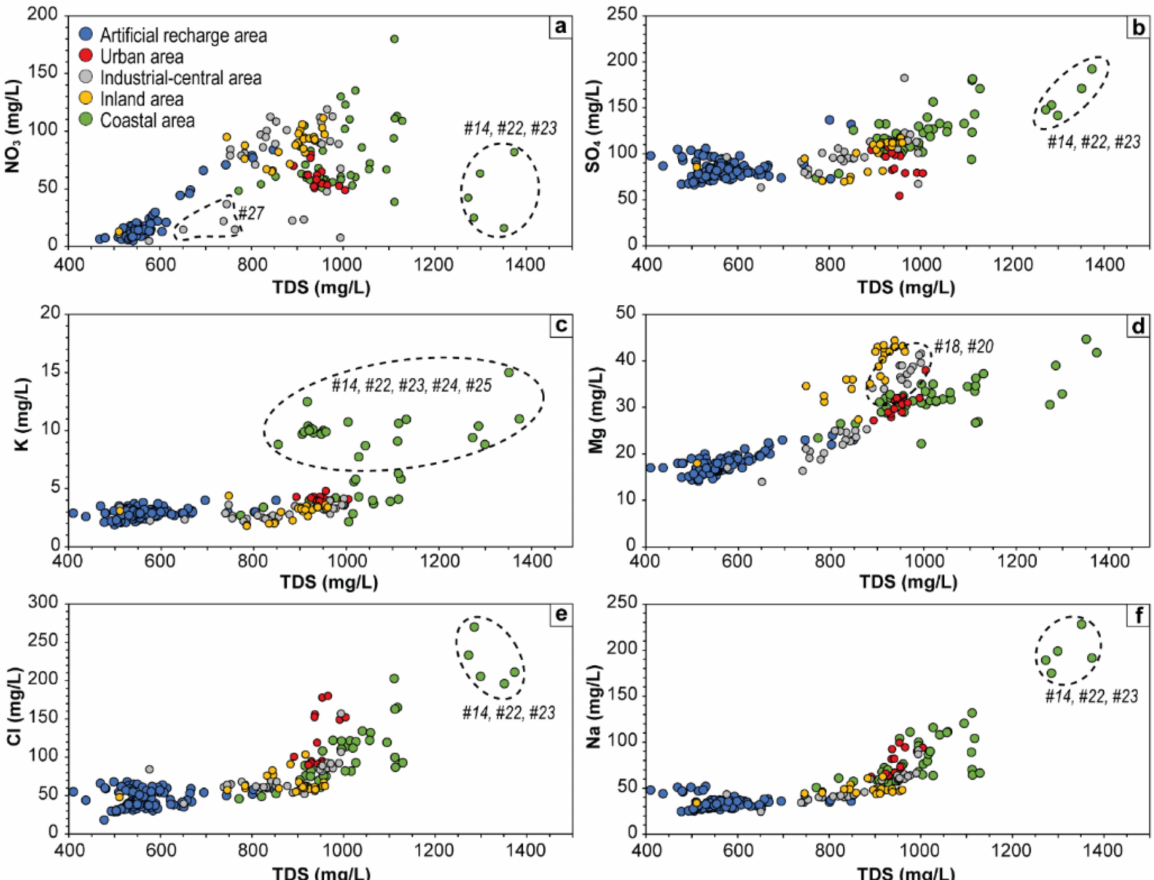
Figure 5. Binary diagrams of ( a ) NO 3 − , ( b ) SO 42 − , ( c ) K + , ( d ) Na + , ( e ) Cl − and ( f ) Mg 2+ vs. TDS (in mg/L) in the shallow groundwater system of the Metauro River